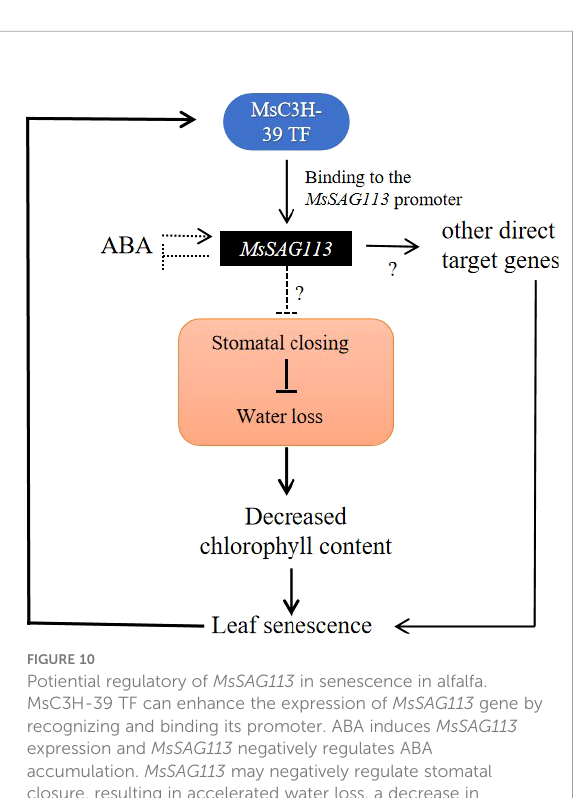
FIGURE 10 Potiential regulatory of MsSAG113 in senescence in